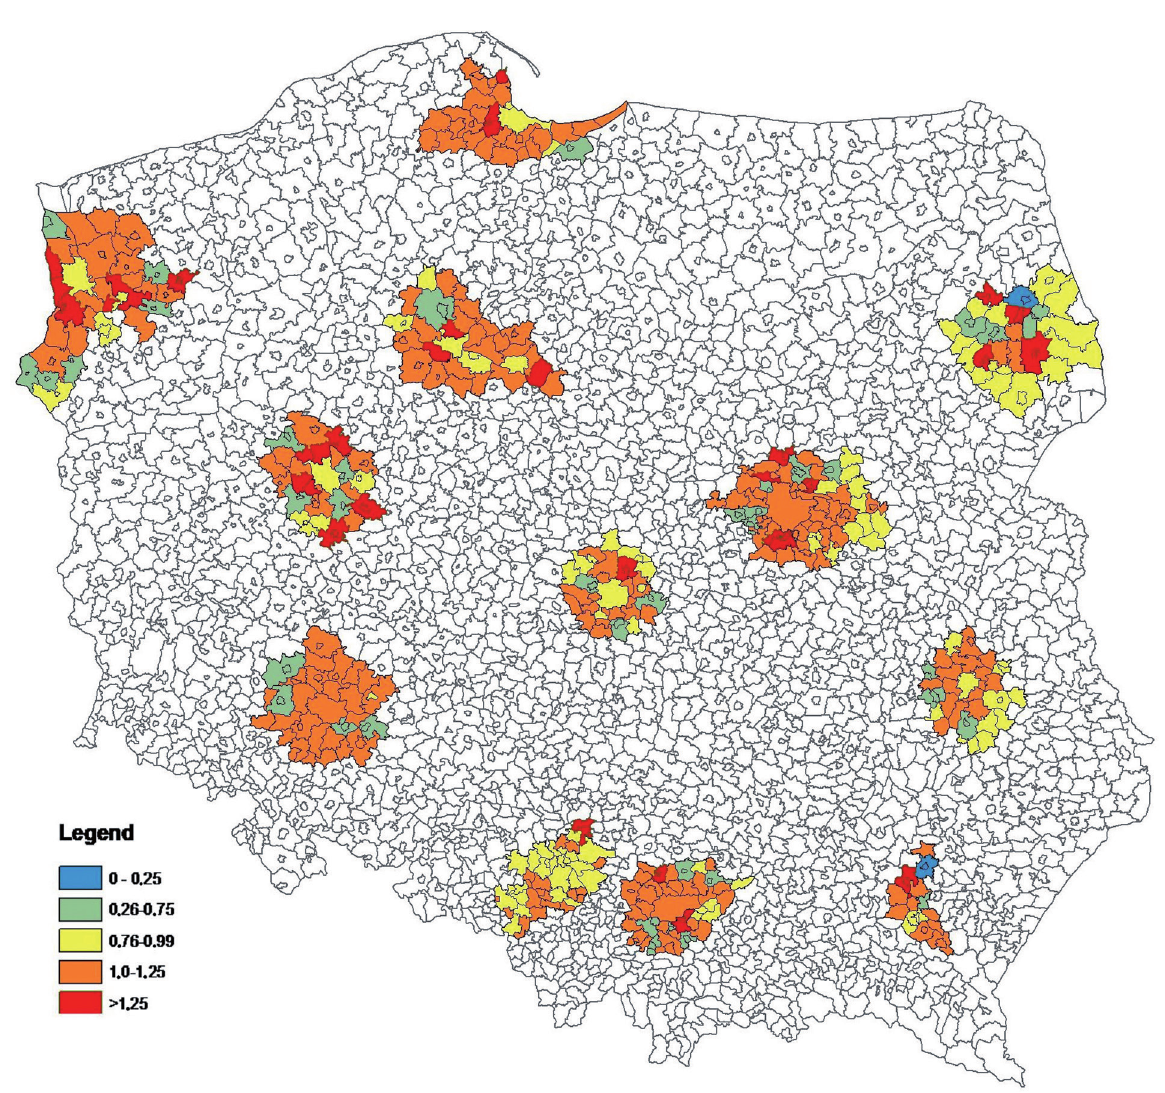
Fig. 2. Dynamics of spatial interactions in municipalities of the metropolitan areas of Poland (2006/2000, see explanation in